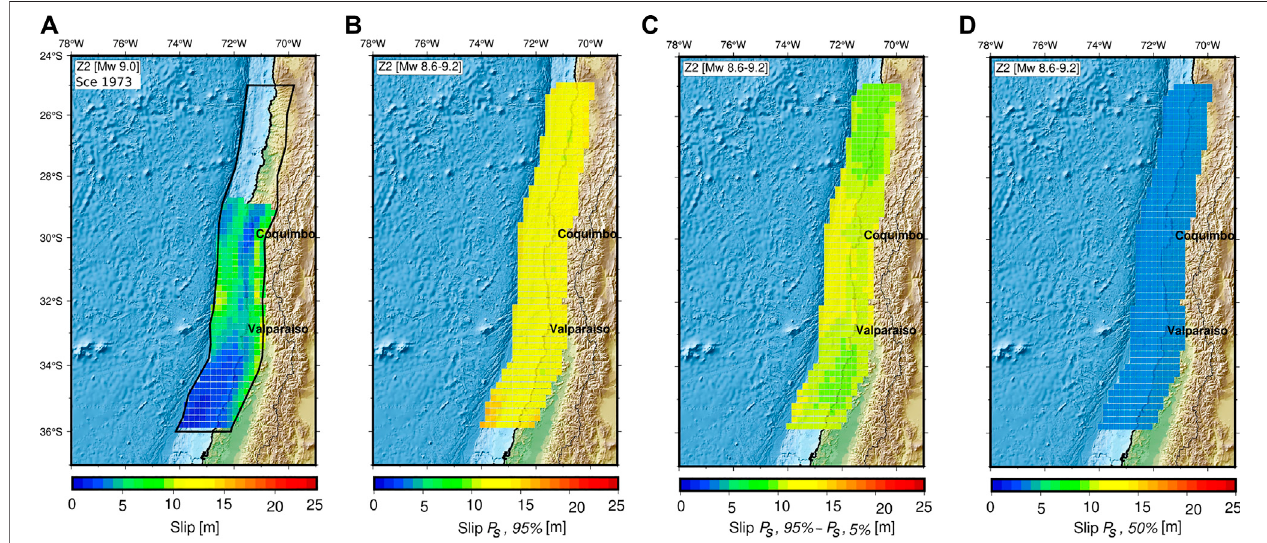
FIGURE 4 | Statistics of the slip distribution estimated at each cell including all seismic scenarios generated using the K-L expansion for the range M w 8.6 to M w 9.2 (A) One scenario ( M w 9.0) is shown as an example (B) P s , 95% slip values (C) P s , 95% − P s , 5% slip values; and (D) P s , 50% , median slip values.